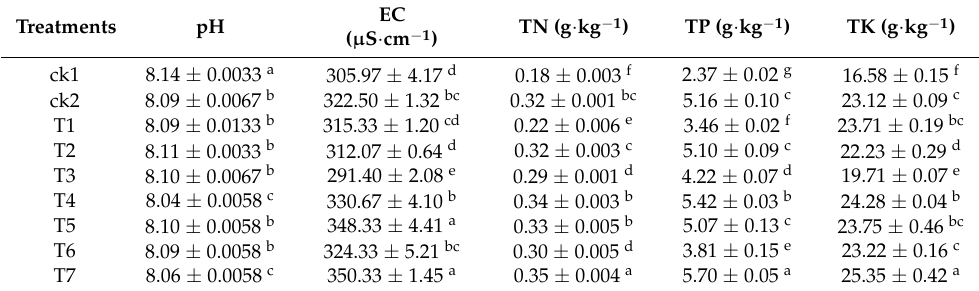
Table 1. Effects of different composting treatments on soil TN, TP, TK, pH, and